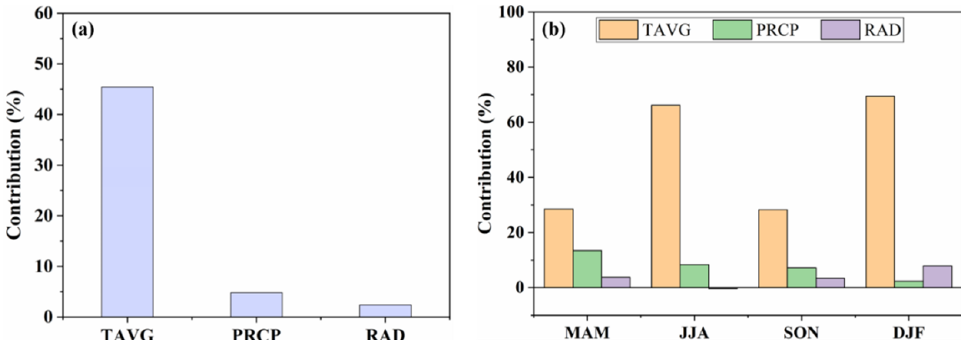
Figure 10. The contributions of climate variables to IAV of NEP in ( a ) annual and ( b ) seasonal timescales.